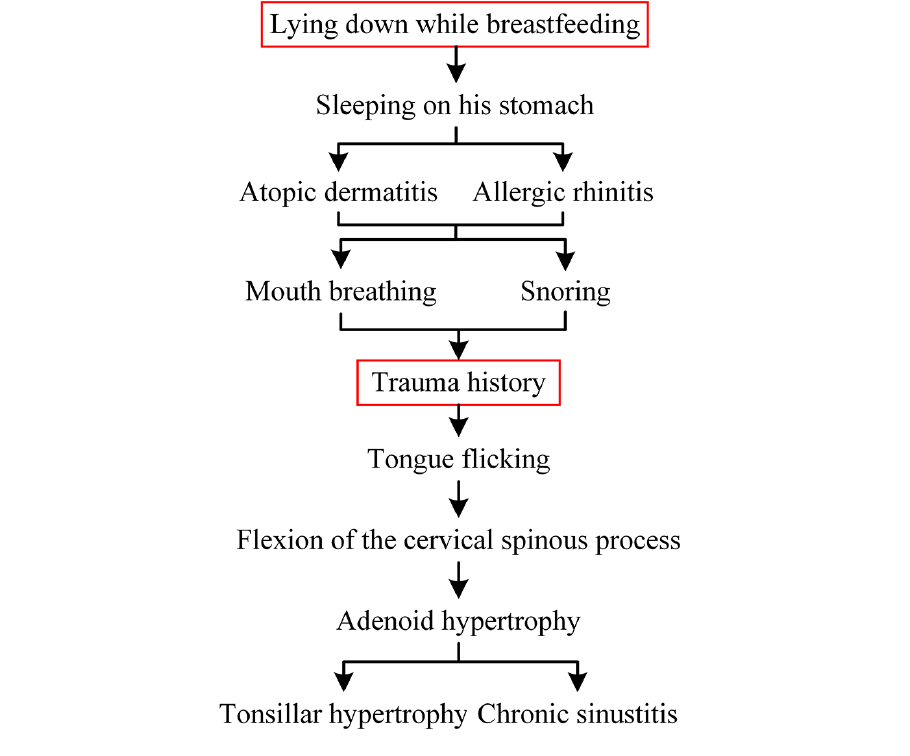
Figure 13. The whole timeline of the disease history.